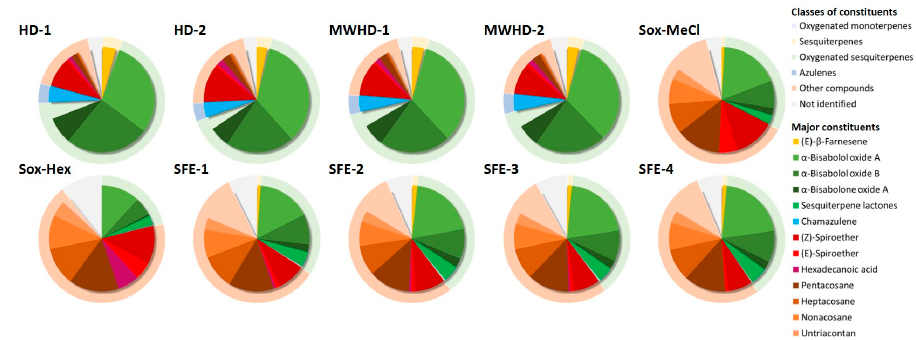
Figure 4. The main class of constituents and the main compounds determined by GC analysis.